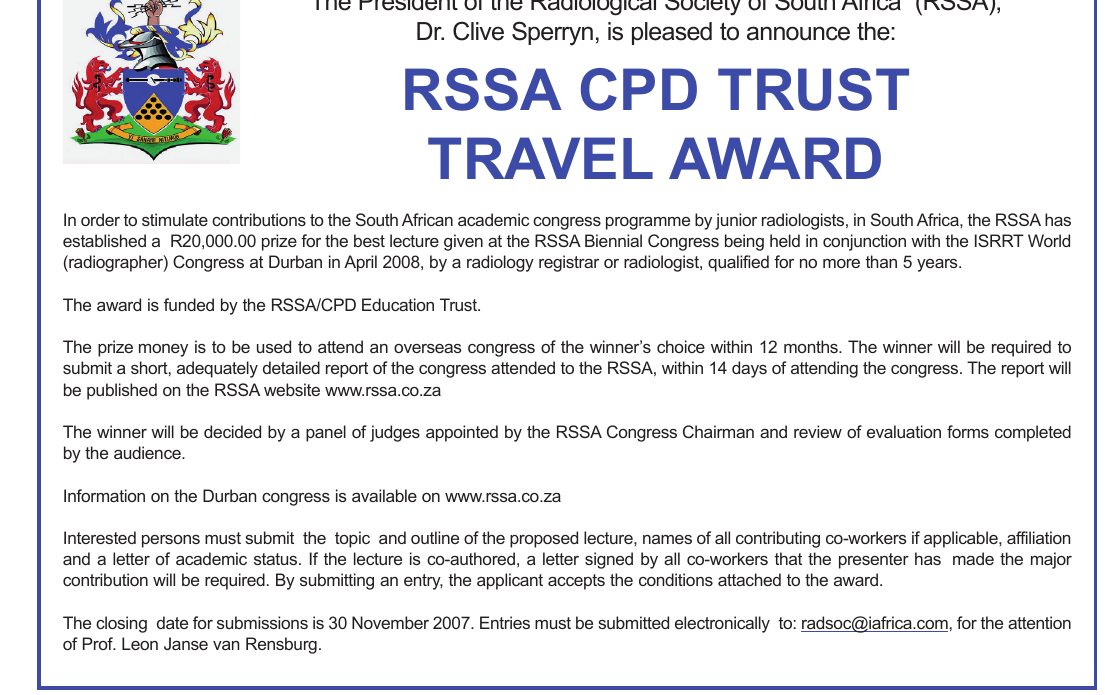
The President of the Radiological Society of South Africa (RSSA), Dr. Clive Sperryn, is pleased to announce